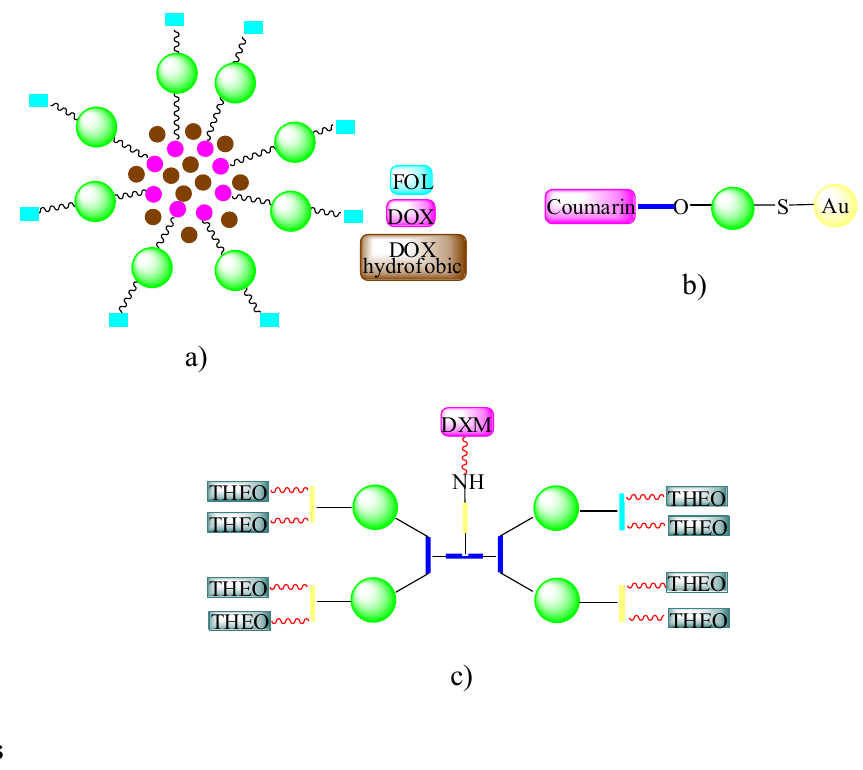
Figure 4. Some example of the structure of PEG conjugates bearing different molecular moieties on the same support: ( a ) Folic acid (FOL)-PEG-Doxorubicine (DOXO)—Nano